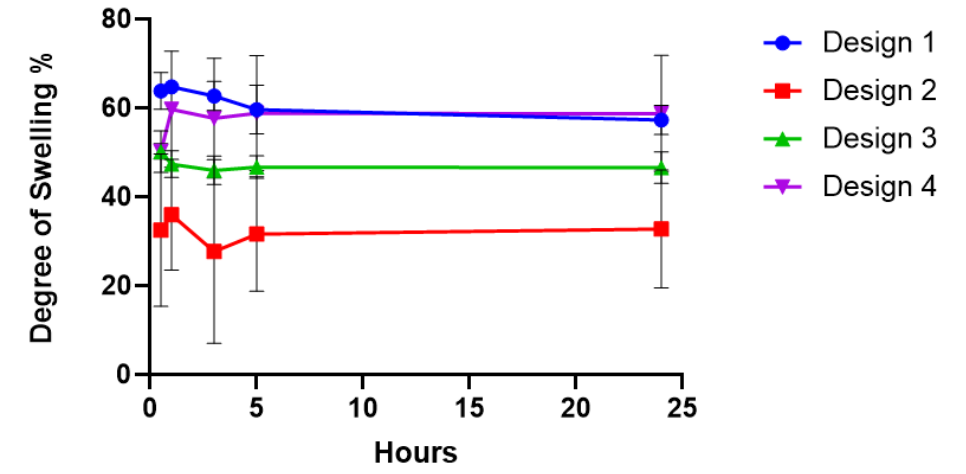
Figure 6. Degree of GelMA hydrogel swelling over 24 h in each of the four scaffold designs.